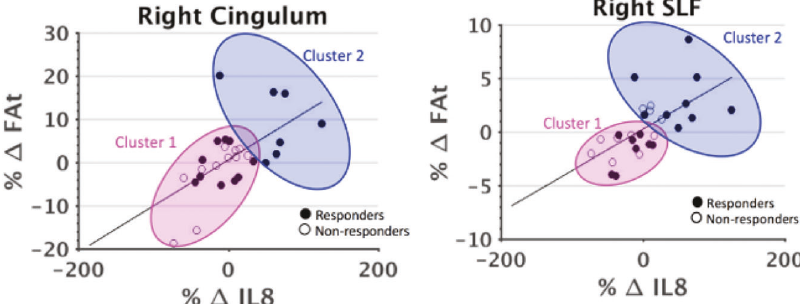
Fig. 5 Trajectories of IL-8 and FAt in selected tracts. Using a linear mixed-effects model, the longitudinal trajectories of IL-8 and FAt were shown to be signi fi cantly correlated in responders in the Right SLF (above) after multiple comparison correction ( p sig = 0.025) (error bars represent s.d.).These trajectories were not correlated in non-responders. A similar trend (not shown) was observed in the right Cingulum